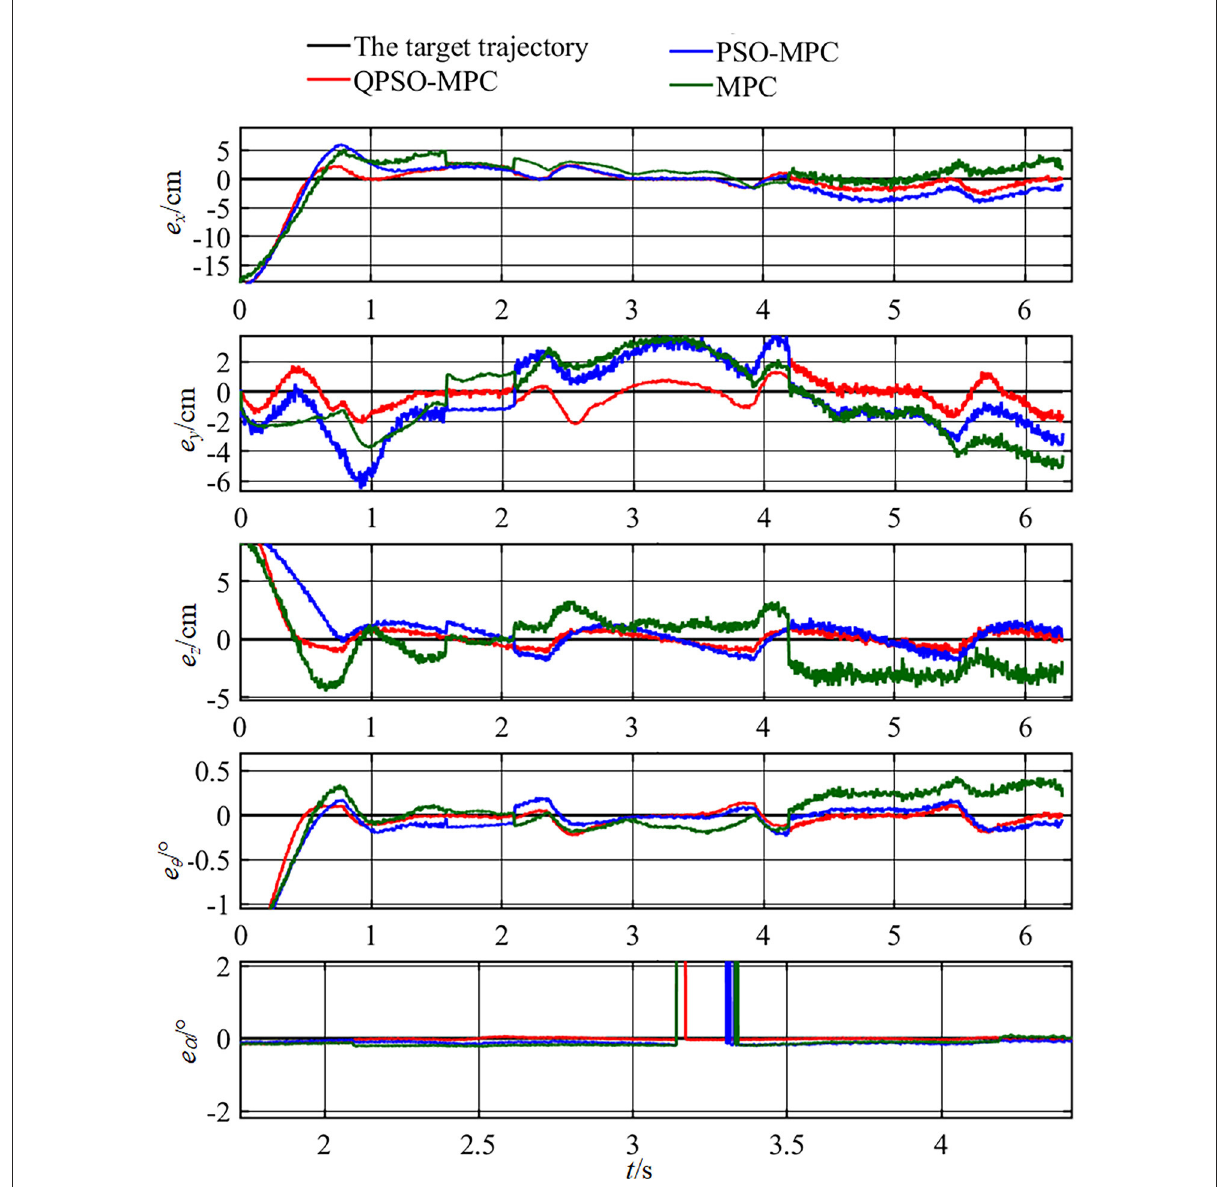
FIGURE11 Tracking errors of the polyline trajectory